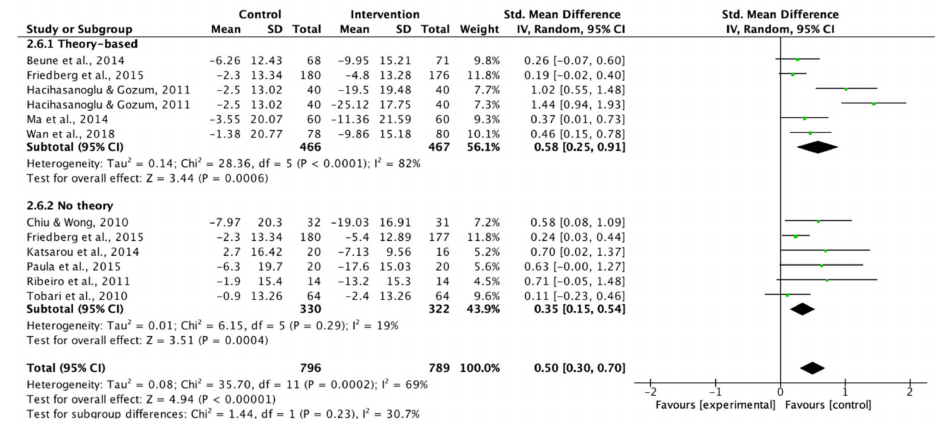
Figure 8. Forest plot of theory-based interventions on systolic blood